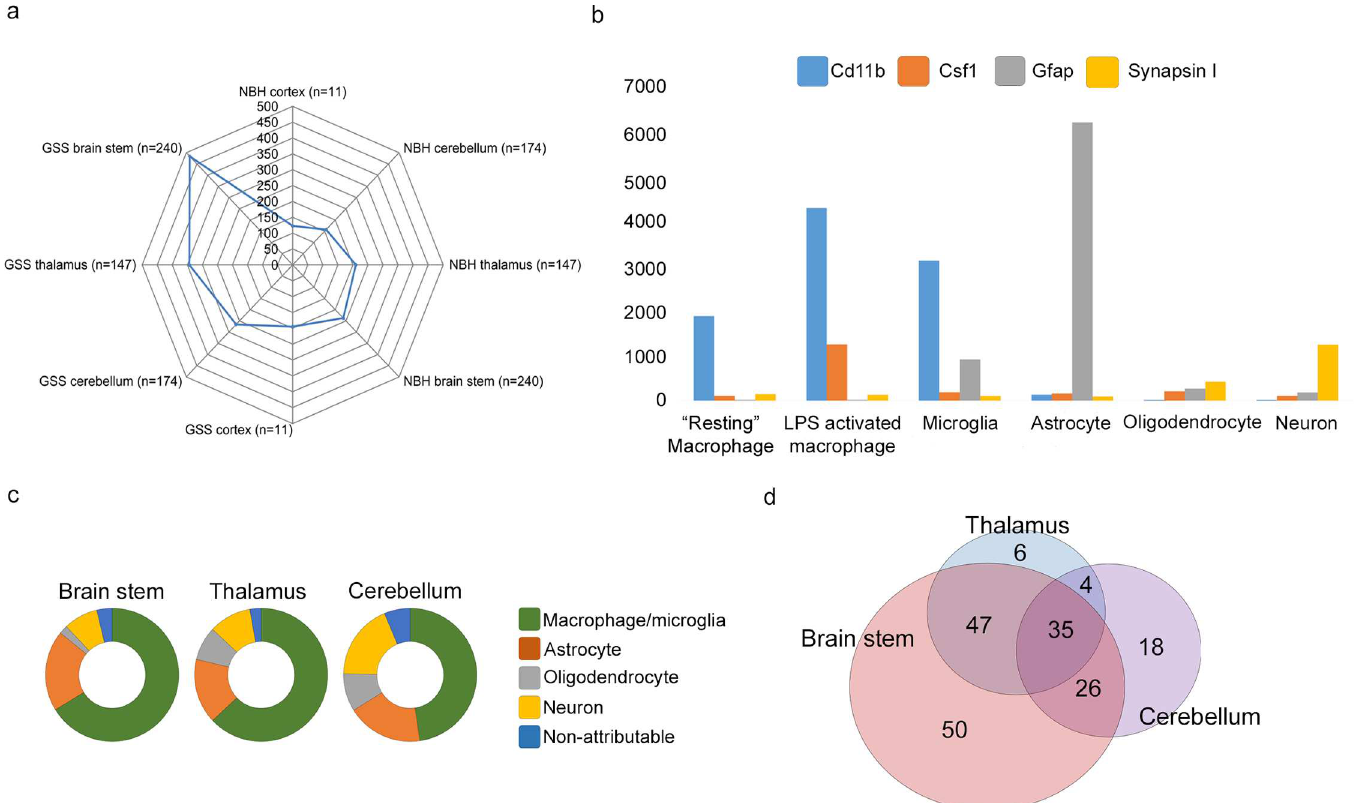
Fig 7. Disease-associated gene expressionchanges can be predominantly attributed to microglia in all GSS/101LL brain regions tested. (a) Spider graph representation of componentB genes after filtering.Up-regulationof genesin all GSS/101LL brain regions, but particularlyincreasedin GSS/101LL brain stem and thalamuscomparedto GSS/101LL cerebellumand cortex. N = number of genes present after data are filtered that constitute the average intensity value. The number of genesrepresentedis highest in GSS/101LL brain stem but lowest in GSS/101LL cortex. (b) Gene expressioncan be attributed to specific cell types when overlaidonto previous microarray datasets. These data show a simplifiedversionto demonstrate how different genesthat are known to have selective expressionin specific cell types in vivo can be attributed to their expectedcell type. For example,Cd11bis a gene generallyregarded as a pan-macrophagemarker, and hencewe show the increasedexpressionof this gene in macrophage/microglial cell populationscomparedto other cell types. Colony-stimulating factor 1 (Csf1) is a gene that is up-regulated duringimmune cell activation, shown here by its increasedexpressionin lipopolysaccharide-activated macrophages. Gfap is a gene expressedhighlyin astrocytes, and, indeed,we show the high and specific expressionof Gfap in astrocytes in this dataset. Finally, synapsinI is a synaptic-specific protein and therefore will most commonly be expressedin neurons, as is shown here. (c) Attribution of genesthat are identifiedin componentb to their respectivecell type shows that a majority of genesthat are identifiedin componentb can be attributed to macrophage/microglia. (d) Representation of the macrophage/microglia genelist overlap of different brain